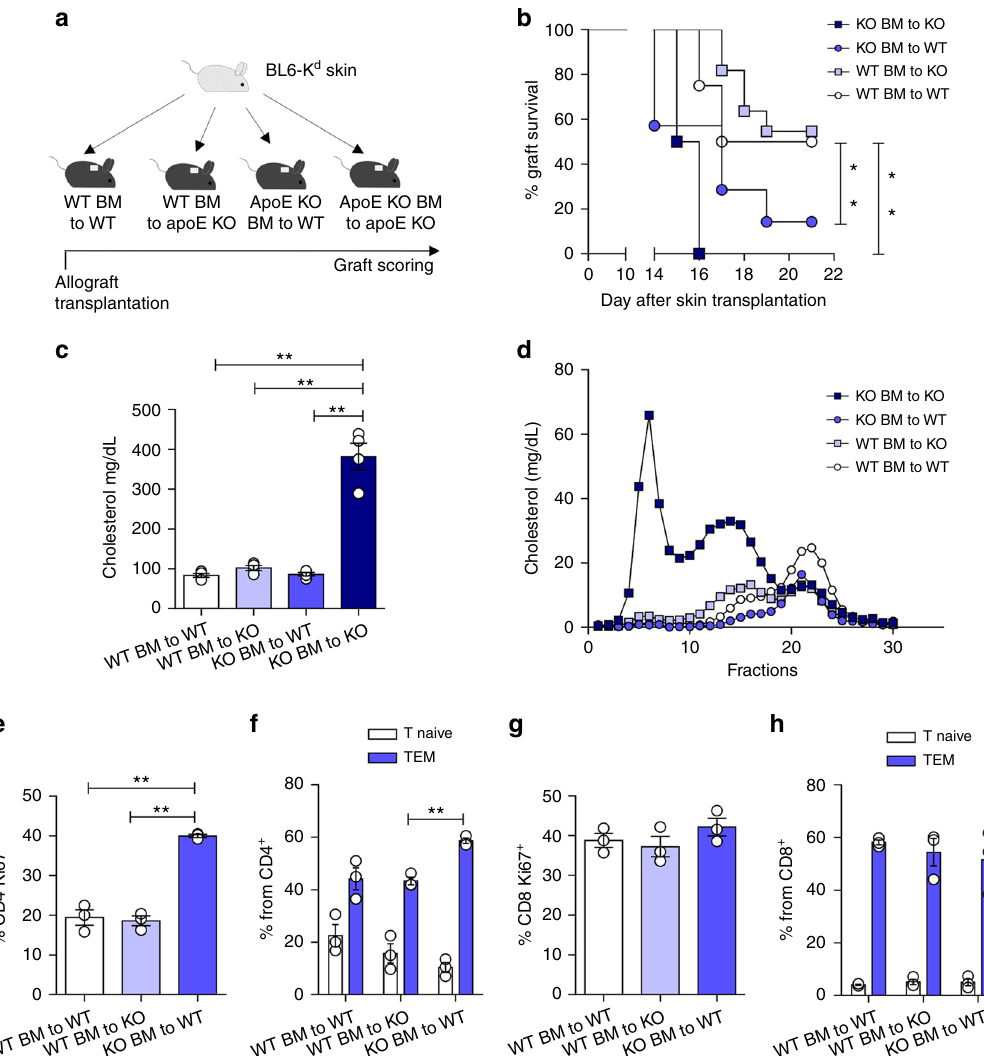
Fig. 2 Hematopoietic de fi ciency of apoE promotes allograft rejection and allogenic T-cell expansion. a Graphic representation of skin allograft transplantation experiment: a piece of tail skin from C57BL/6K d donor was transplanted on the back of bone marrow transplanted (BMT) WT and apoE KO (BMT) mice; graft survival was scored up to 3 weeks. b Percentage of graft survival following skin allotransplantation in BMT mice. Survival of <50% of the donor skin was recorded as rejection. c Plasma cholesterol determination (mg/dL) after allograft rejection in BMT mice. d FPLC pro fi les of cholesterol distribution in the different lipoprotein subclasses (VLDL, LDL and HDL) from pooled plasma of grafted BMT mice ( n = 4 for each group). e and g Proliferation of CD4 + ( e ) and CD8 + ( g ) lymphocytes isolated from draining lymph nodes of BMT-grafted mice, determined as Ki67 + staining following challenge with splenocytes isolated from C57BL/6K d donor. f and h Polarization of CD4 + ( f ) and CD8 + ( h ) lymphocytes isolated from draining lymph nodes of BMT-grafted mice toward T EM subset after challenge with splenocytes isolated from C57BL/6K d donor. N = 4 per group. Statistical analysis was performed with Gehan-Breslow-Wilcoxon test ( b ) and two-way Anova ( c , e – h ). Data are reported as mean ± SEM; * p < 0.05, ** p <